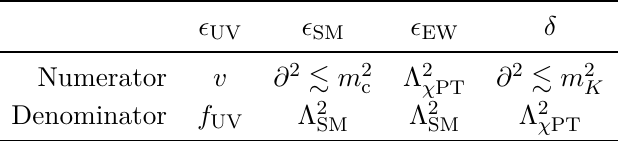
of U(3) χ PT. Λ = 4 πv and SM c , one K